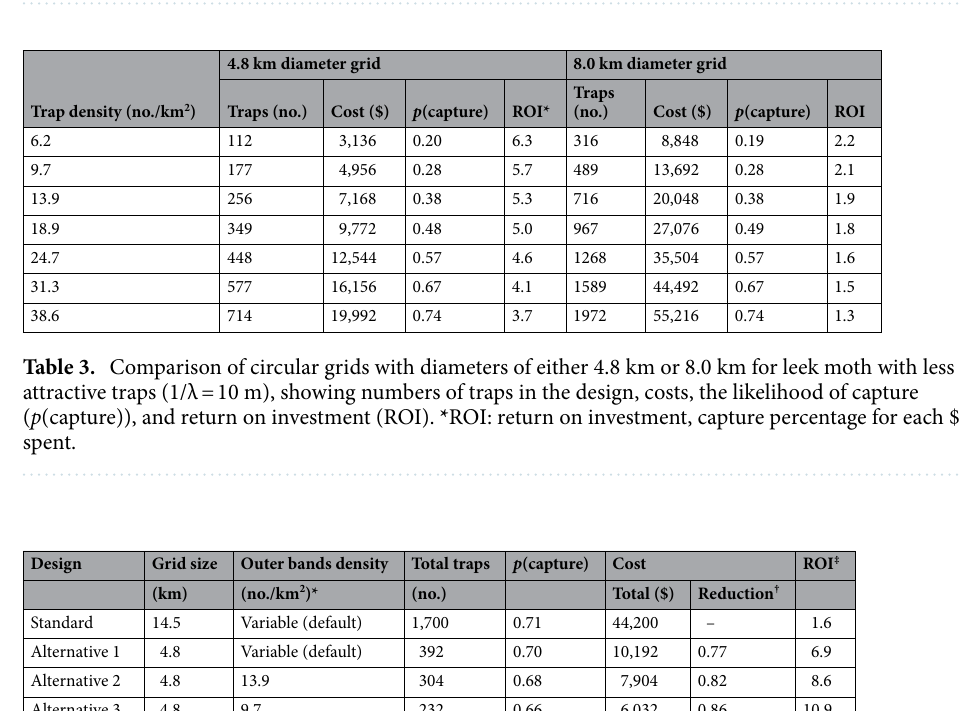
Figure 5. Improved designs for delimiting surveys for ( a ) leek moth, using a 4.8-km diameter circle with 9.7 traps per km 2 , and ( b ) Medfly, with a 4.8-km diameter circle with 38.6 traps per km 2 in the core and 9.7 traps per km 2 elsewhere.